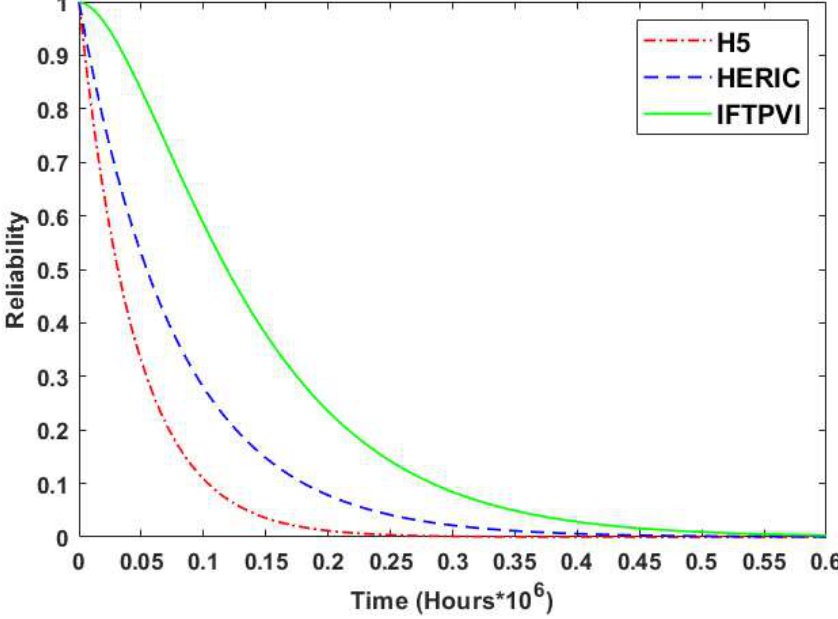
Figure 12. Reliability comparison of the IFTPVI versus the conventional HERIC and H5 inverters.